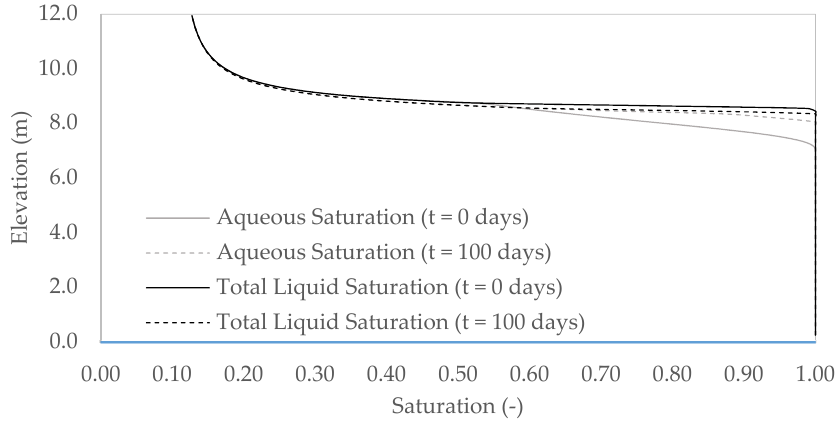
Figure 12. Aqueous and total saturation variation (initial and final) in TE8 under 24.93 kPa for oxisol.